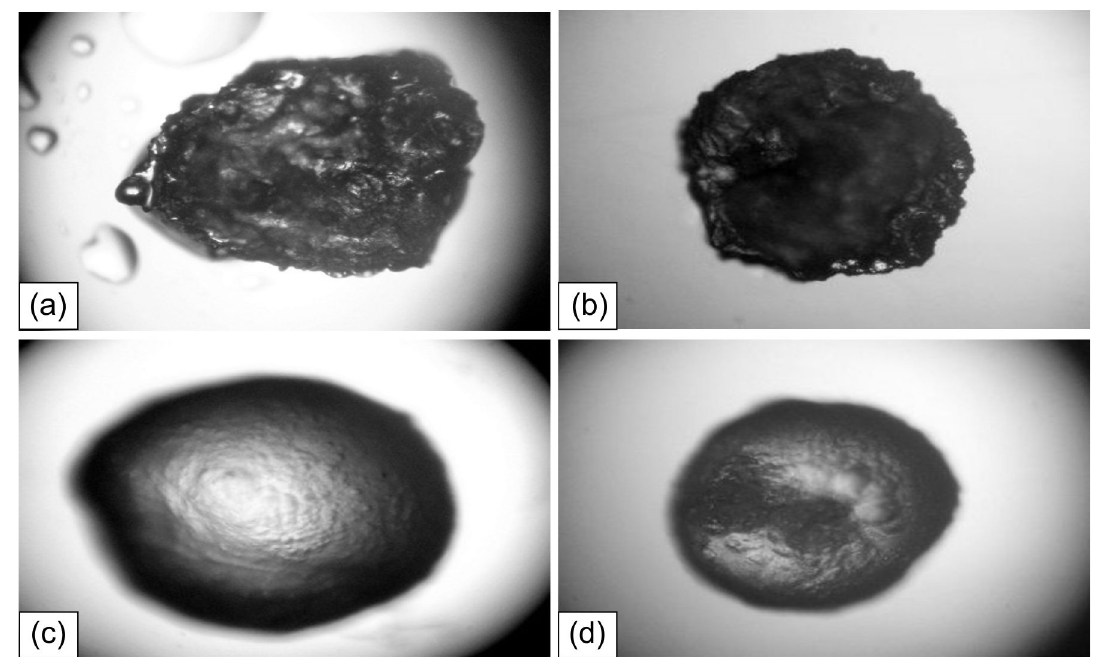
FIGURE 1 - (a) Lyophilized microparticles without starch; (b) Lyophilized microparticles with starch; (c) Microparticles without starch dried in air column (d) Microparticles with starch dried in air column at mo (40x). SOURCE: The author